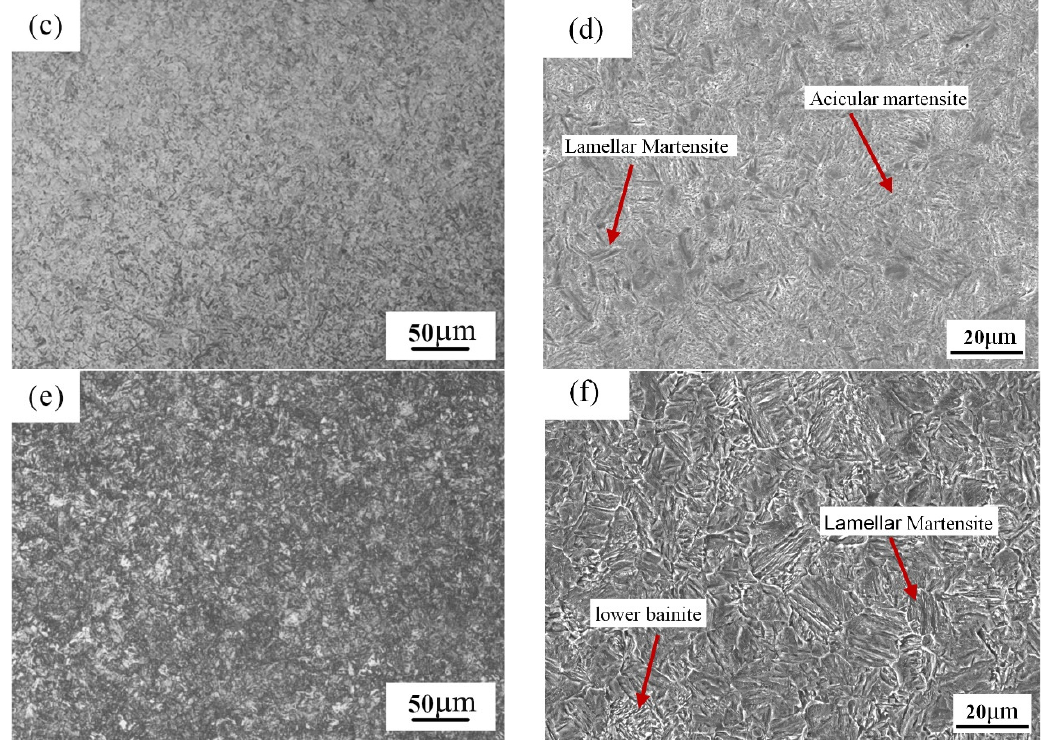
Figure 8. 20CrMnTiH organization after carburizing ( a ) OM surface; ( b ) SEM surface; ( c ) OM transition; ( d ) SEM transition; ( e ) OM center; and ( f ) SEM center.